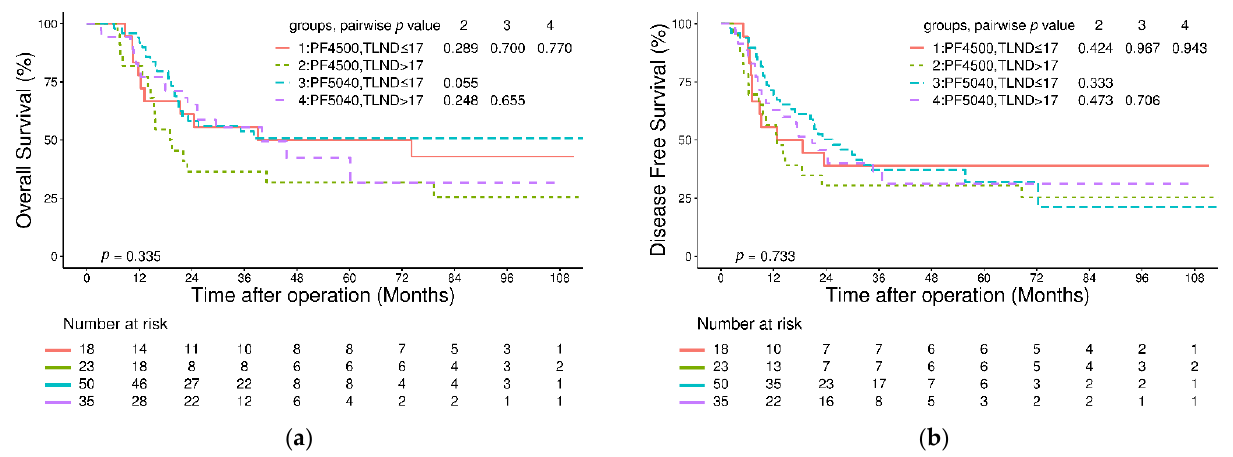
Figure 2. ( a ) Kaplan – Meier analysis of overall survival in the entire cohort stratified according to regimens and total LND numbers; ( b ) Kaplan – Meier analysis of disease-free survival in the entire cohort stratified according to regimens and total LND numbers. Abbreviations: TLND: total lymph node dissection.